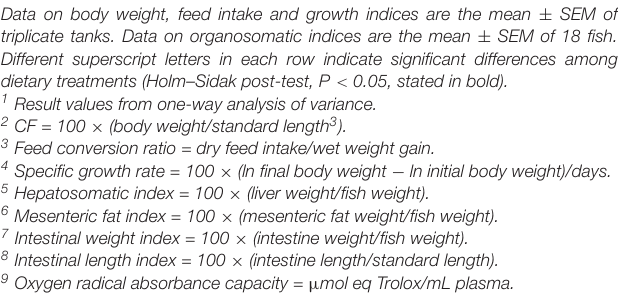
Different superscript letters in each row indicate significant differences among dietary treatments (Holm–Sidak post-test, P < 0.05, stated in